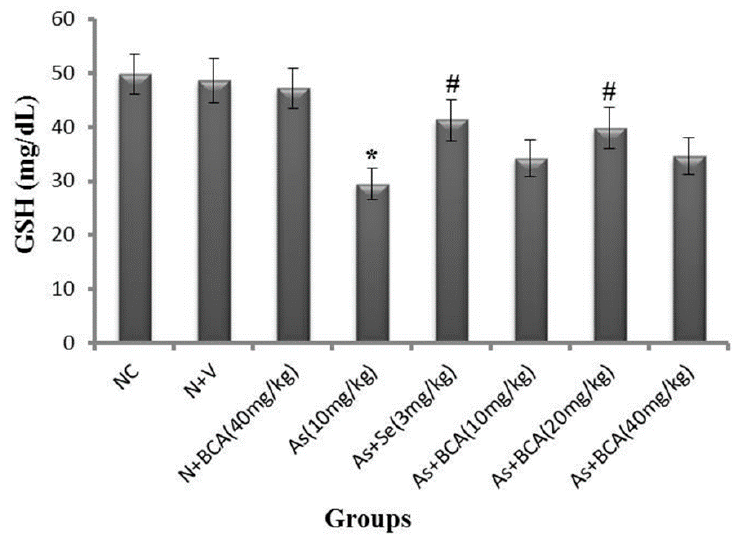
Figure 2. Differences between the level of plasma GSH in normal control and experimental rats.